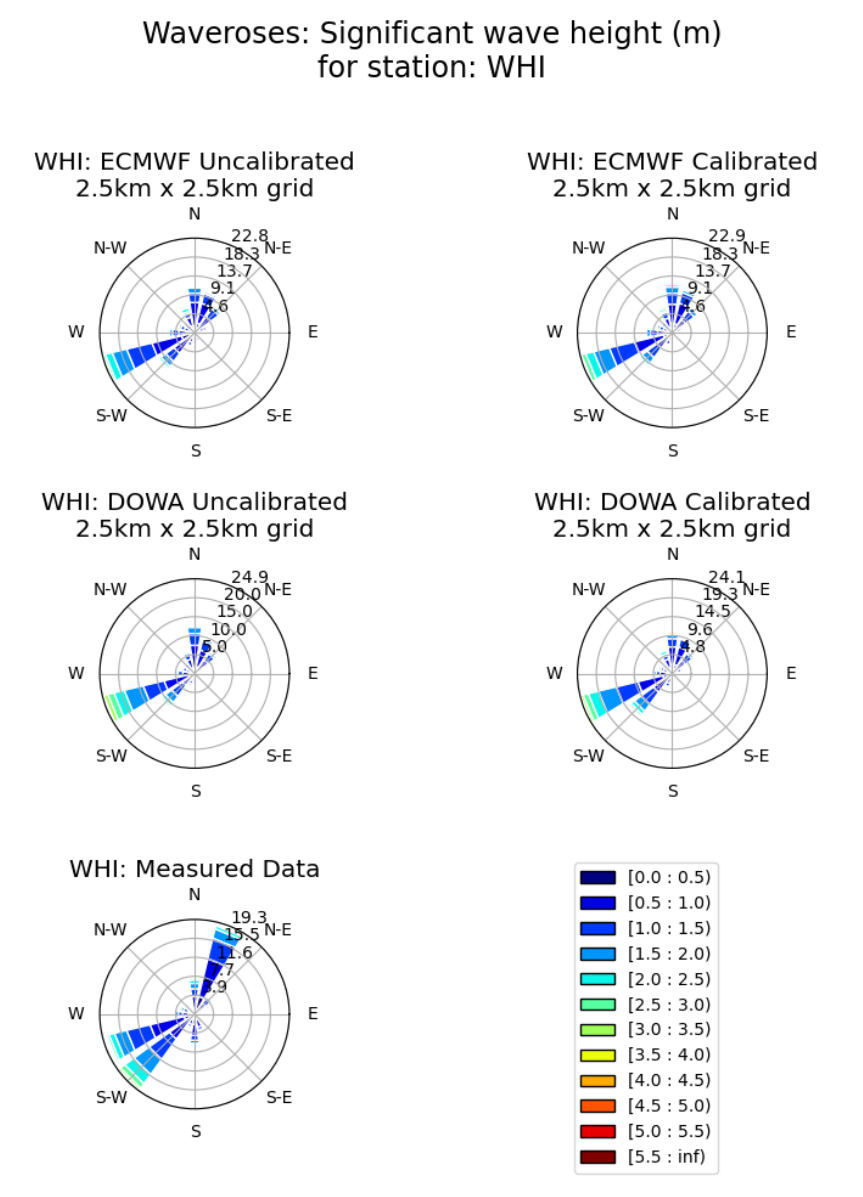
Figure 7. Wave roses (significant wave height) for the 2.5 km computational grid showing the measured data, the calibrated and uncalibrated SWAN models forced with the ECMWF-ERA5 and DOWA wind databases.